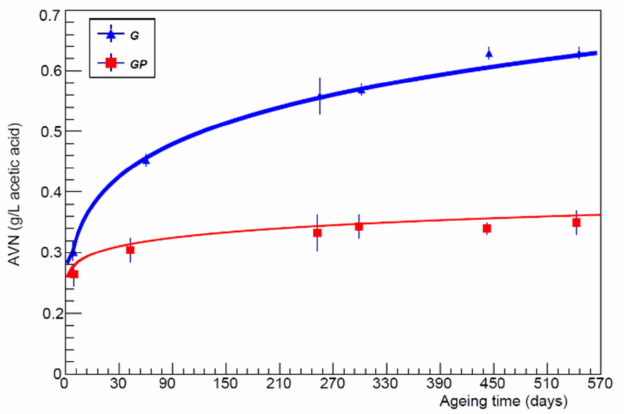
Figure 3. The AVN trend as a function of the aging time (days) for each vineyard and in both protocols.